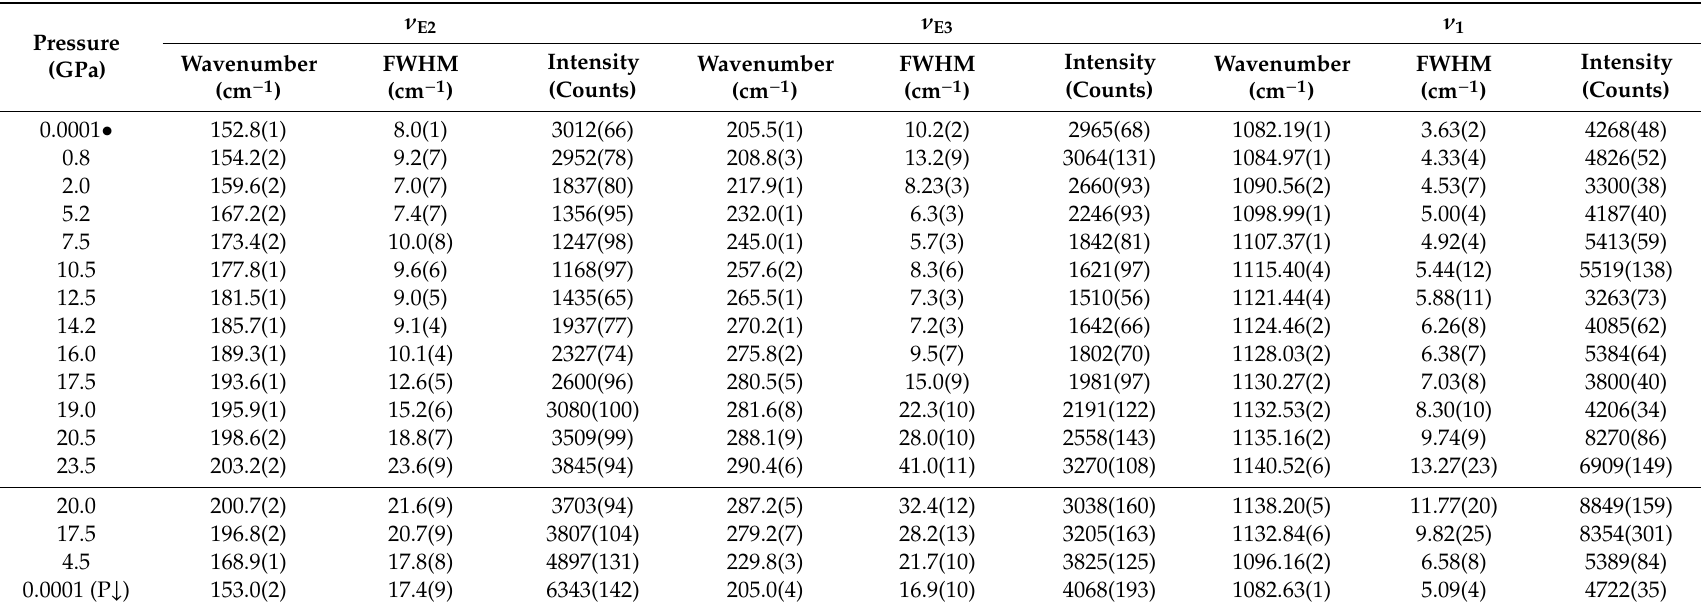
Table 3. Experimentally determined Raman mode wavenumber, FWHM and intensity of aragonite as a function of